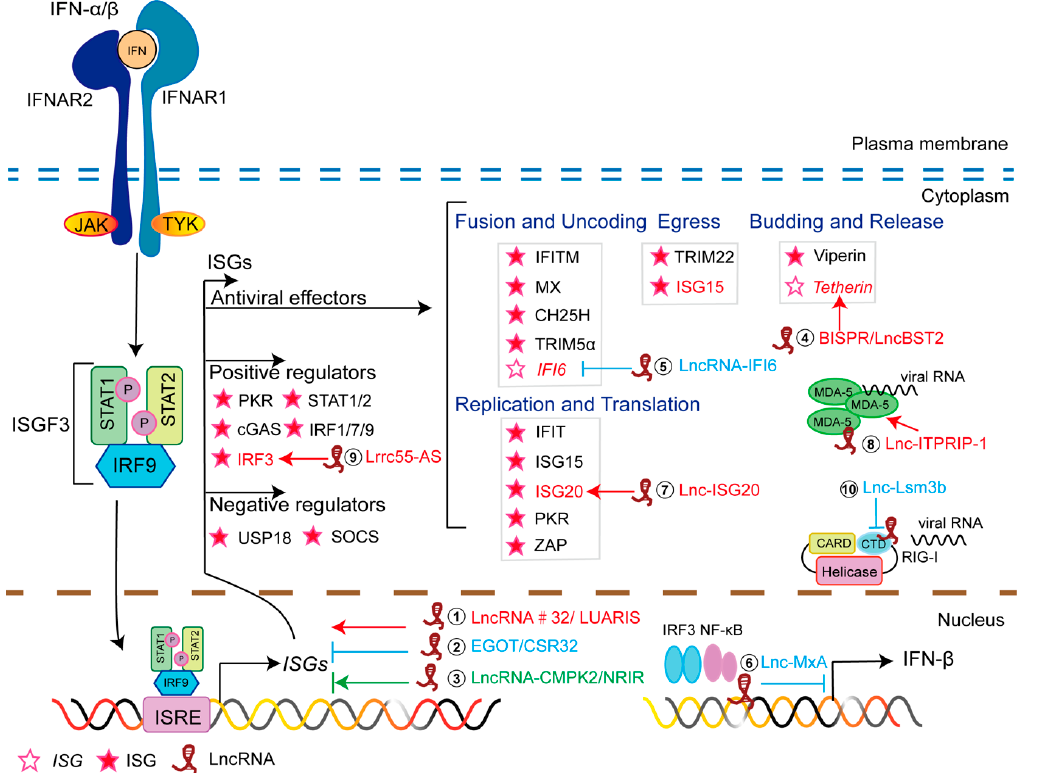
Figure 2. Antiviral innate immunity induced through ISGs. ISG products interfere with different stages of viral life cycles. Long noncoding RNAs (lncRNAs) act as ISGs in the regulation of antivi- ral innate immunity. ① lncRNA #32/LUARIS positively regulates the expression of ISGs by inter- acting with ATF2 and hnRNPU. ② lncRNA EGOT/CSR32 inhibits the expression of ISGs. ③ lncRNA CMPK2/NRIR suppresses ISGs transcription in hepatocytes or epithelial cells, and up-regulates the expression of ISGs in human monocytes. ④ BISPR/lncBST2 promotes the expres- sion of the antiviral ISG BST2/tetherin. ⑤ Through its spatial domain, lncRNA IFI6 regulates his- tone modification at the IFI6 promoter, inhibiting the expression of IFI6. ⑥ lncRNA MxA inhibits the transcription of IFN- β . ⑦ As an endogenous competitive RNA, lnc-ISG20 binds to the mi- croRNA (miRNA) miR-326, releasing ISG20 mRNA from the miRNA. ⑧ lncRNA ITPRIP-1 pro- motes the inhibitory effect of MDA5 by facilitating the binding of MDA5 to viral RNA. ⑨ lncRNA Lrrc55-AS supports PME-1-mediated demethylation and inactivation of PP2A, enhancing IRF3 phosphorylation and signaling. ⑩ lncRNA Lsm3b binds RIG-I, restricting the conformational change in RIG-I protein and thus preventing downstream signaling. Red arrow stands for pro- moting; blue arrow stands for inhibiting; green arrow stands for promoting or inhibiting depend- ing on the cell type. The lncRNAs ① – ⑥ are involved in antiviral factor transcription, and ⑦ – ⑩ affect the antiviral factors post-transcription.